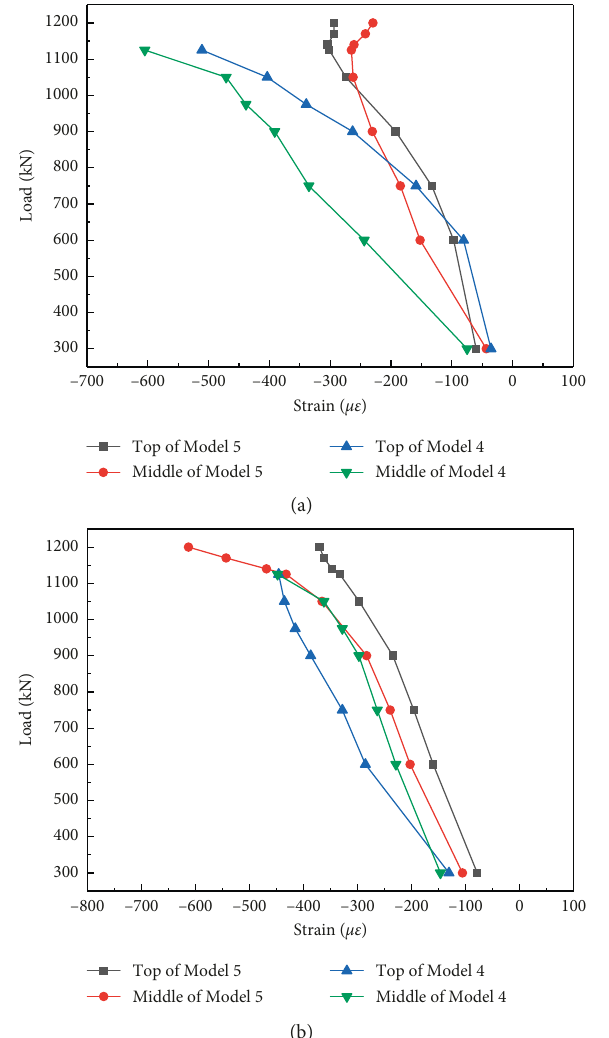
Figure 28: Load-strain curves of vertical rods in Models 4 and 5. (a) Comparison of A3 rod. (b) Comparison of C3